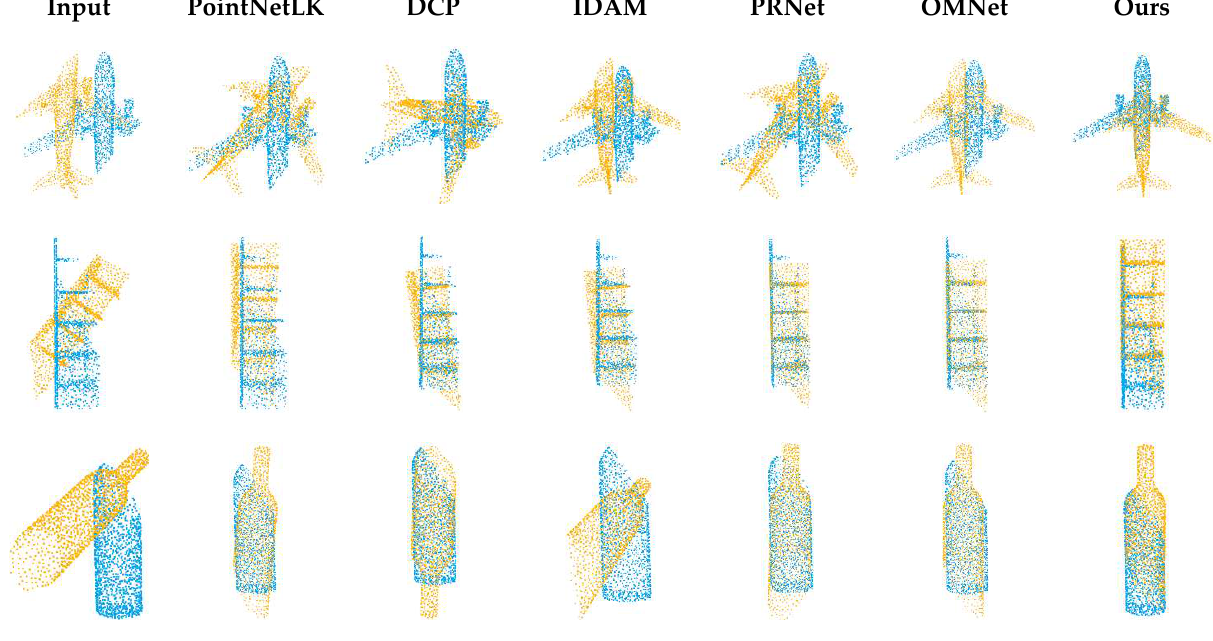
Figure 5. Registration visualization on ModelNet40. Table 1. Results for testing on point clouds of unseen shapes in ModelNet40.